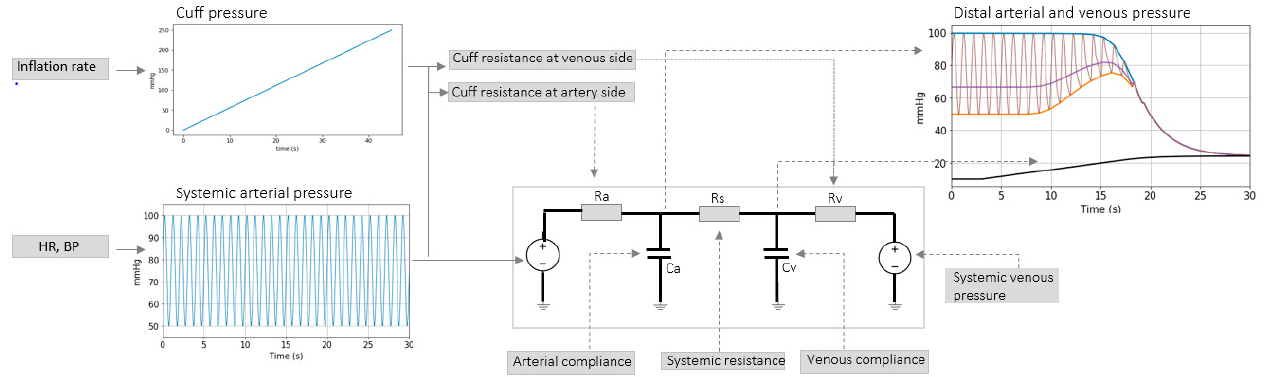
Figure 2. Overview of arm circulation model including a change in R a due to cuff inflation.